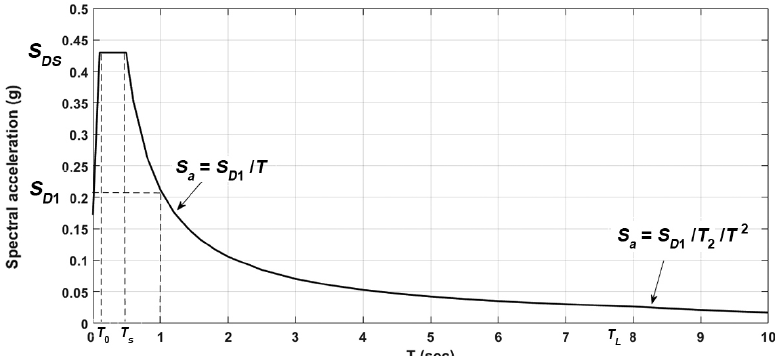
Figure 6. Response spectrum curve obtained for Dubai according to the ASCE 7-16 standard (ASCE,